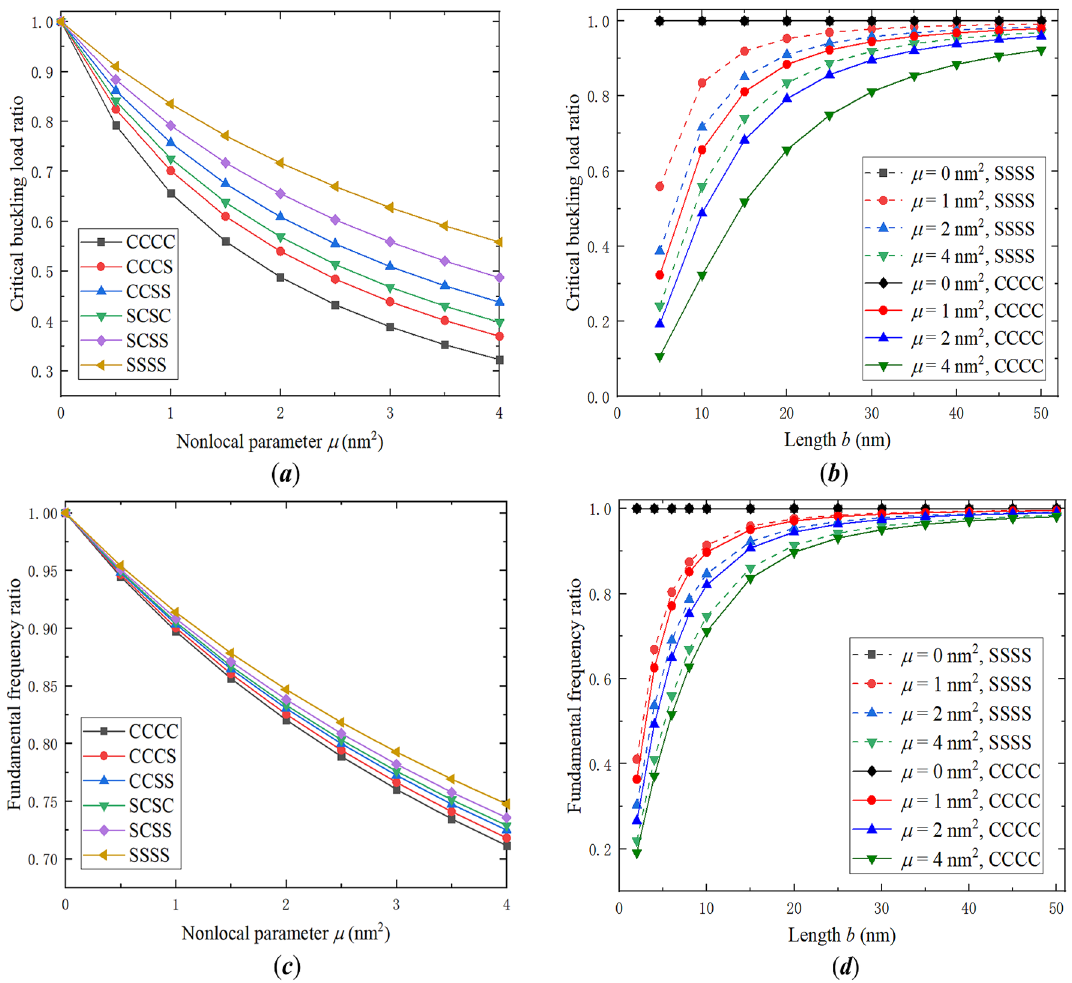
Figure 2. ( a ) Critical buckling load ratios versus the nonlocal parameter of square nanoplates under different BCs. ( b ) Critical buckling load ratios versus the length of square SSSS and CCCC nanoplates with different nonlocal parameters. ( c ) Fundamental frequency ratios versus the nonlocal parameter of square nanoplates under different BCs. ( d ) Fundamental frequency ratios versus the length of square SSSS and CCCC nanoplates with different nonlocal